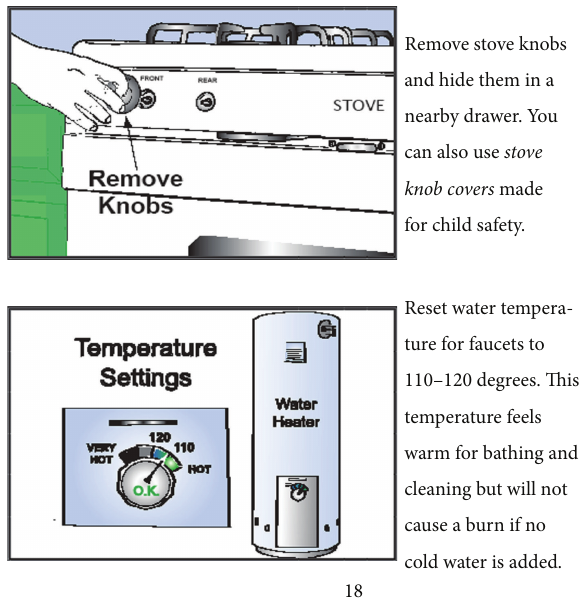
Figure 1: Example of recommendations in Home Safety Toolkit using health literacy